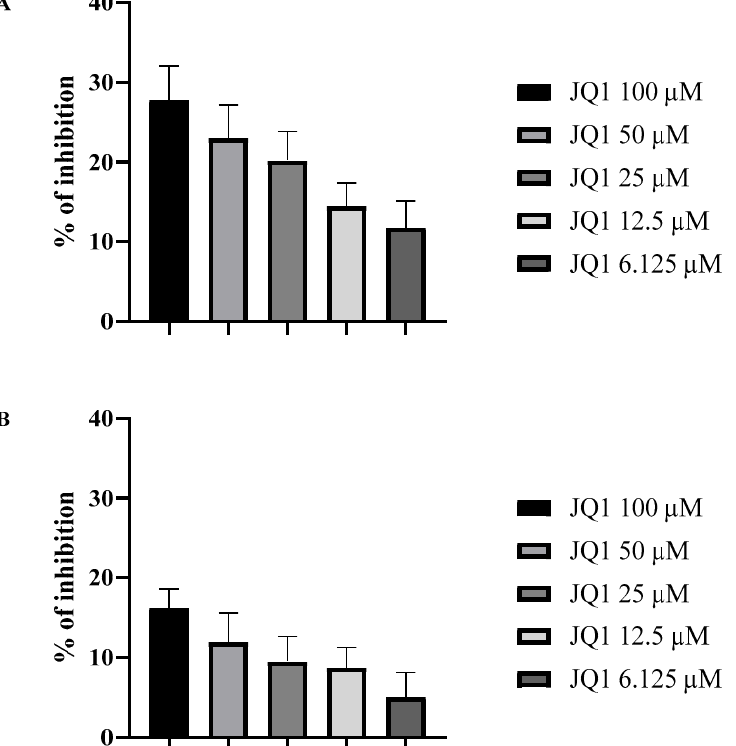
Figure 1. The activity of JQ1 against proliferation of A. fumigatus biofilm ( A ) and metabolic activity of A. fumigatus mature biofilm ( B ). The values are reported as the mean of three experiments performed in triplicate.